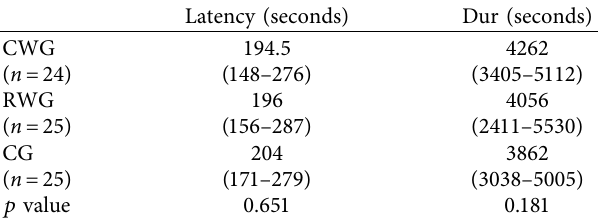
Table 5: Medians (minimum-maximum) and p value for com- parison between